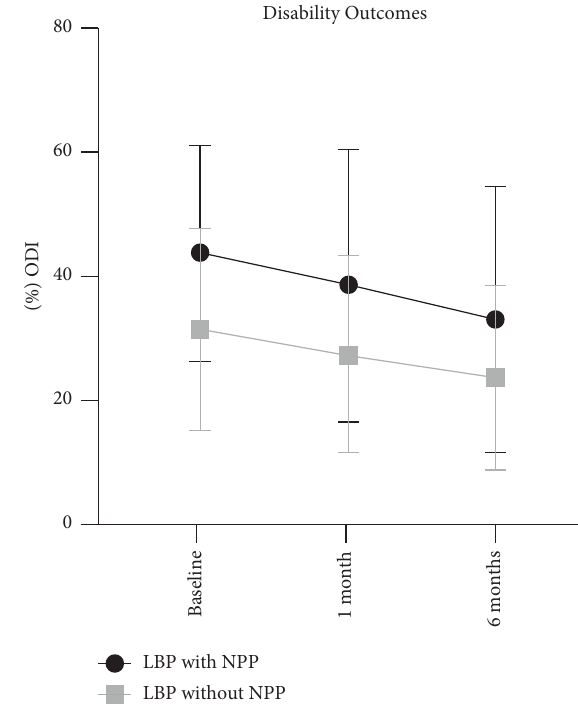
Figure 4: Short- and long-term disability outcomes after physical